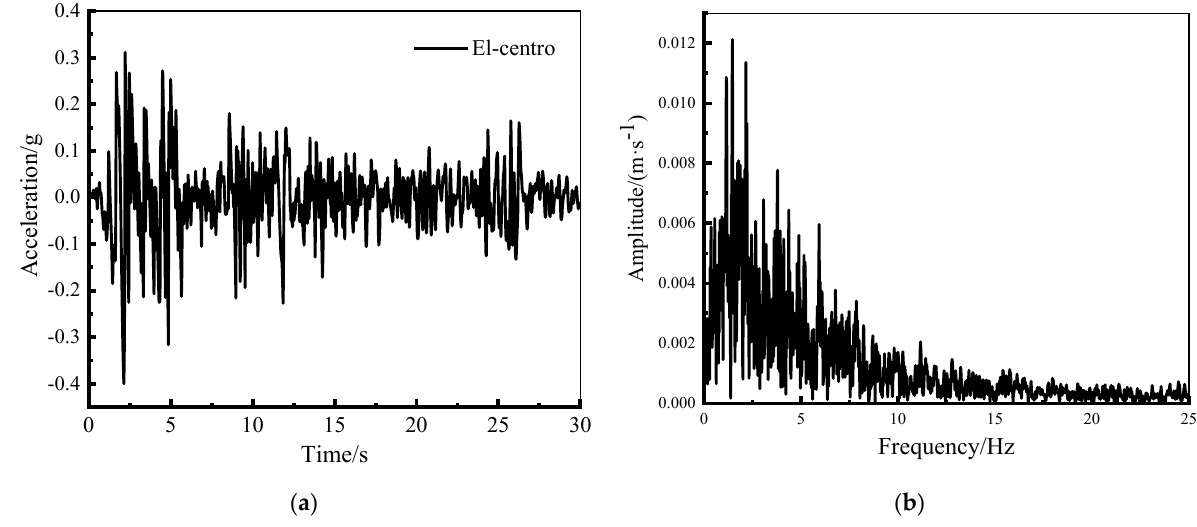
Figure 4. The acceleration time history and Fourier spectra of bedrock ground motion: ( a ) Time history curve of ground motion; ( b ) Fourier spectrum.